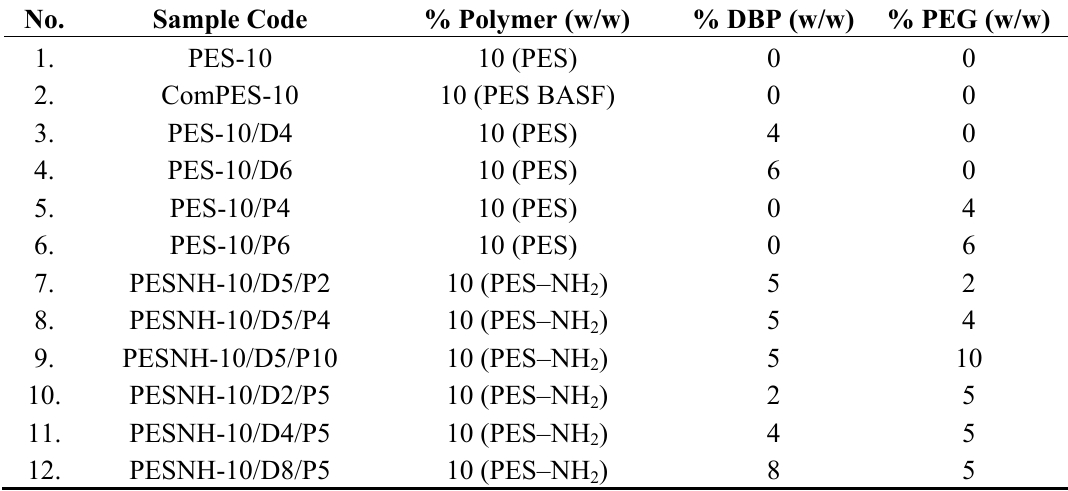
Table 3. Composition of casting solution in membrane